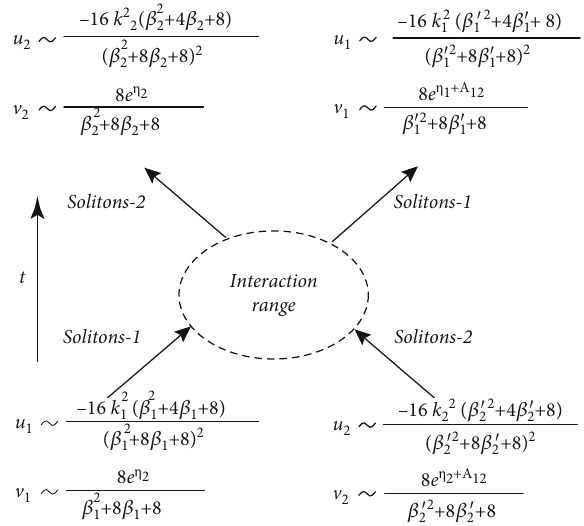
Figure 3: Two-soliton collisions in the coupled KdV